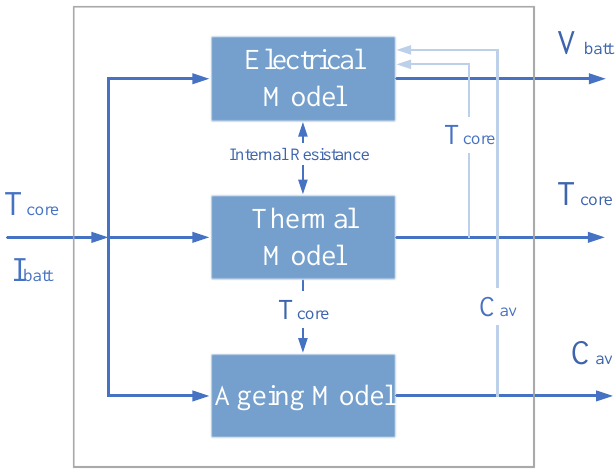
Figure 1. Structure of the complete modeling of the NMC/G 20 Ah pouch cell.